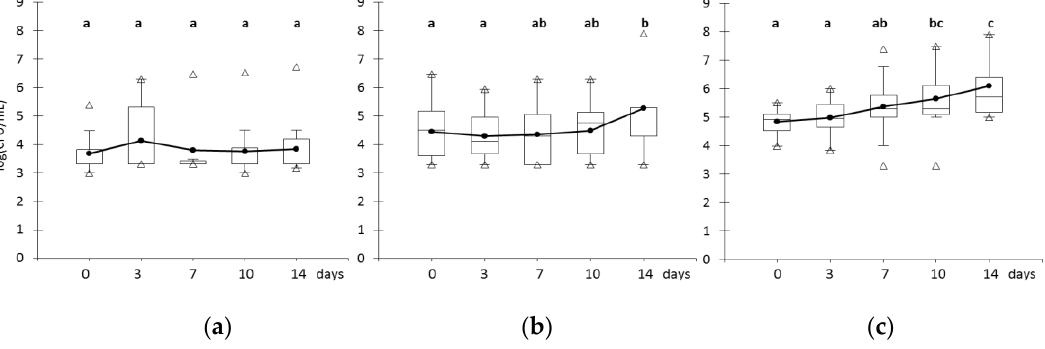
Figure 1. Microbial population (log CFU / g) modifications during refrigerated storage of untreated pineapple juice; ( a ) psychrotrophic bacteria, ( b ) enterobacteria, and ( c ) yeasts and molds. Black circles: mean; open triangle: extreme values; boxes: 1st and 3rd quartiles.